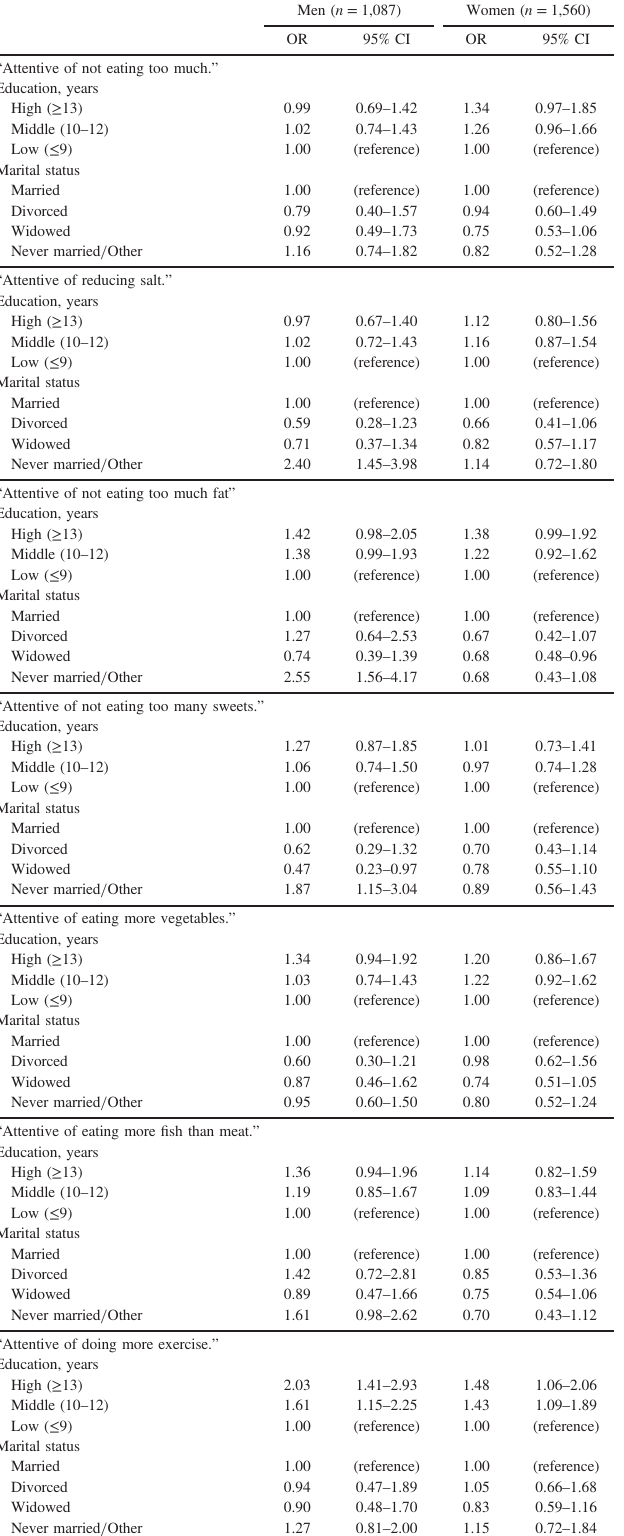
Table 4. Odds ratios and 95% con fi dence intervals of answering “ yes ” to each question on healthy behaviors in the multivariable logistic regression analysis: